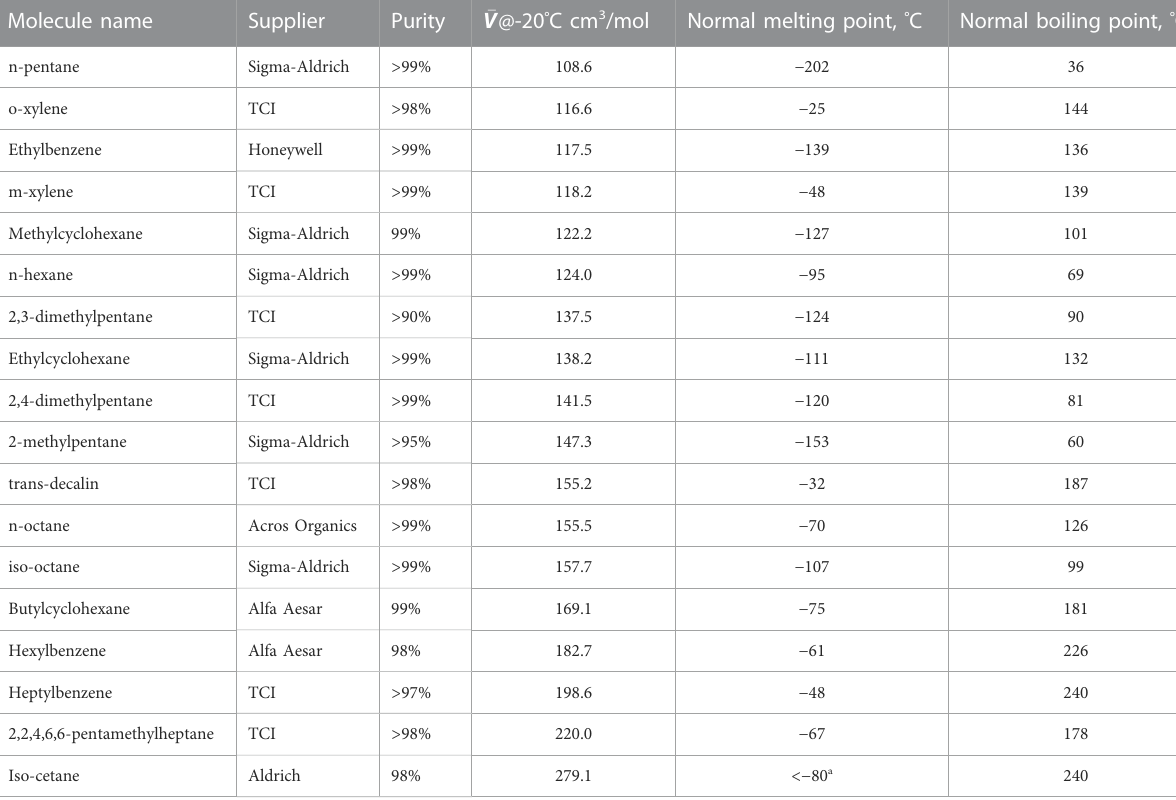
TABLE 1 List of pure materials used as stock for the mixtures